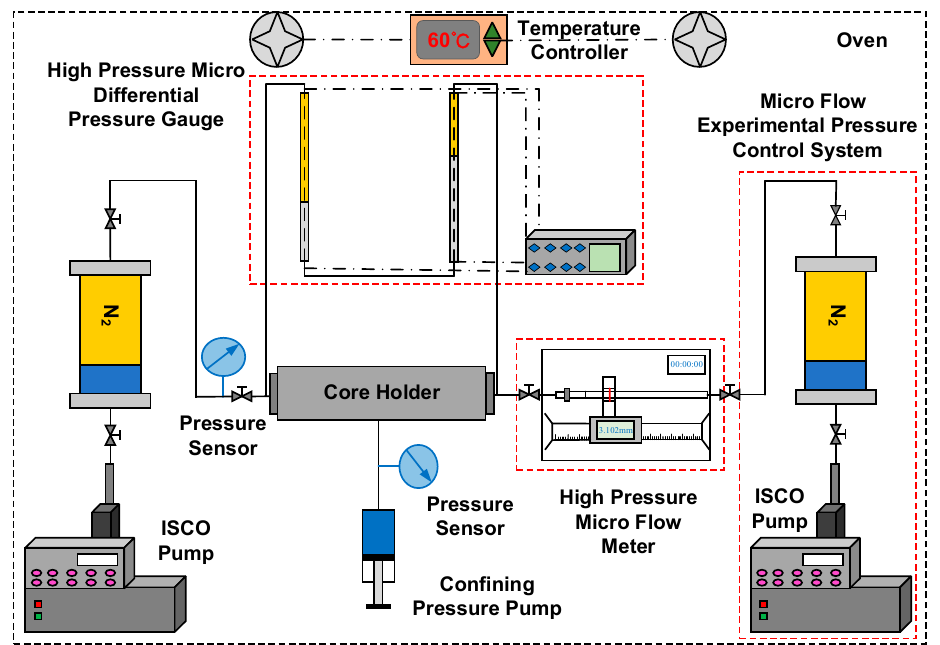
Figure 2. Schematic diagram of the experimental device.